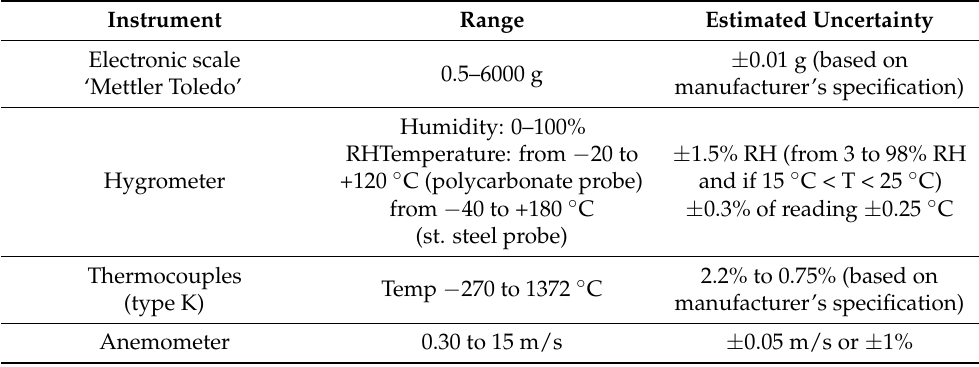
Table 3. Uncertainties in the measurement of parameters during drying of